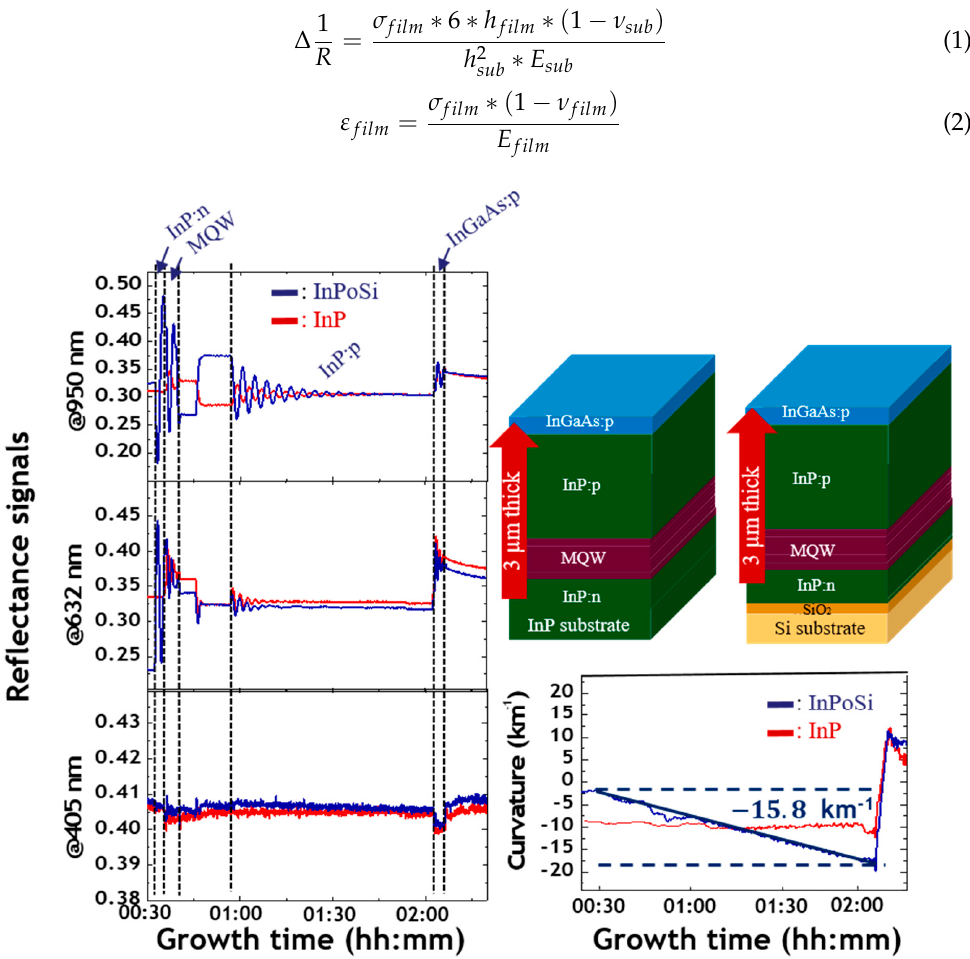
Figure 2. In situ measurements during growth: reflectance signals measured at 950, 632 and 405 nm and curvature measurement.